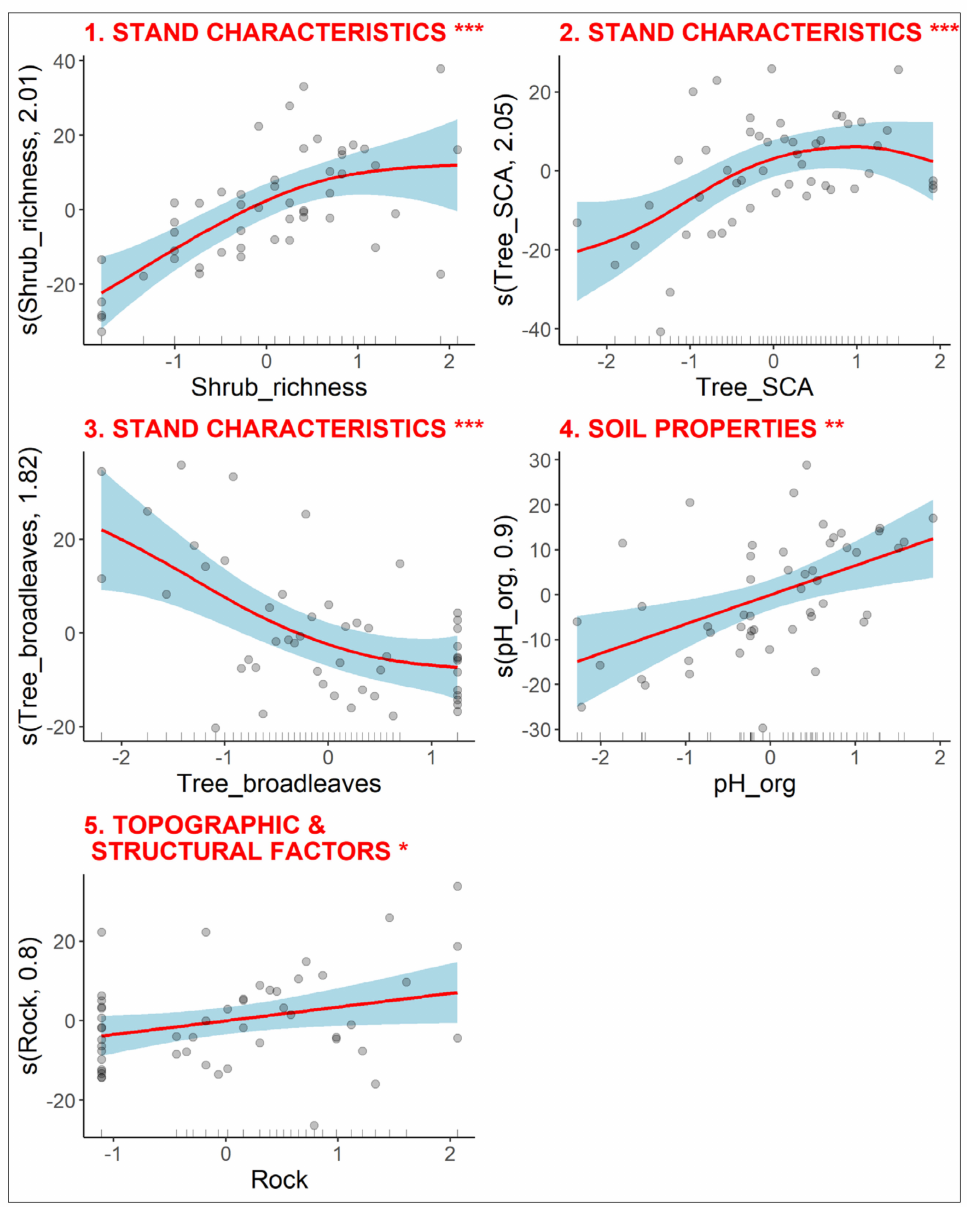
Figure 2. The estimated relationships between the herb-layer species richness and five explanatory variables included in the final generalized additive model (GAM): shrub layer richness, tree-layer shade-casting ability (SCA), proportion of broadleaves in the tree layer, pH of the organic soil layer and cover of rocks. The order of predictors reflects their effect size and significance: *** p < 0.001, ** p < 0.01, * p < 0.05. The confidence interval (95%) is indicated with the light-blue ribbon around each curve. For additional definition of predictors, see Table